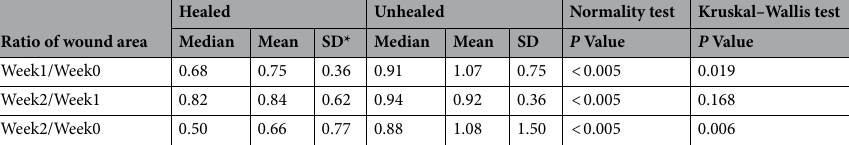
Table 2. Kruskal–Wallis test—comparison between ratio of the ulcer areas across three weeks and the healing status at week 12. *Standard deviation from the mean.